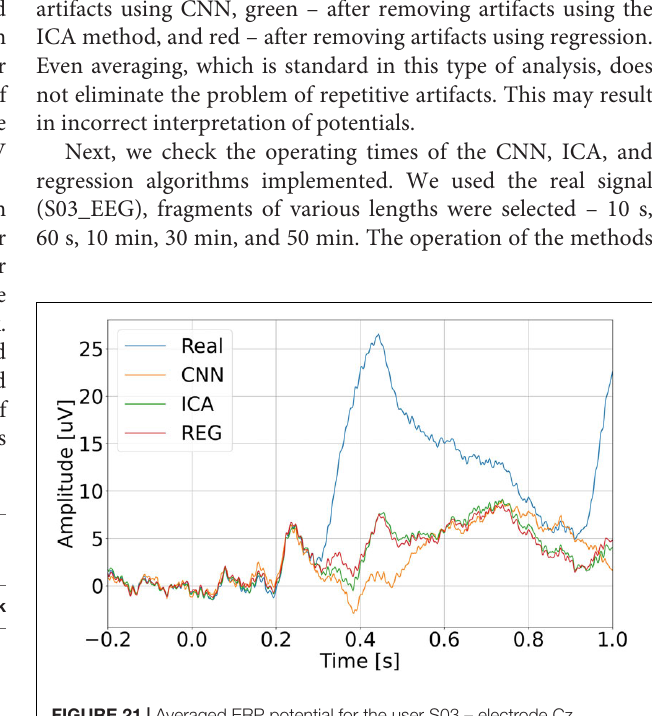
FIGURE 21 | Averaged ERP potential for the user S03 – electrode